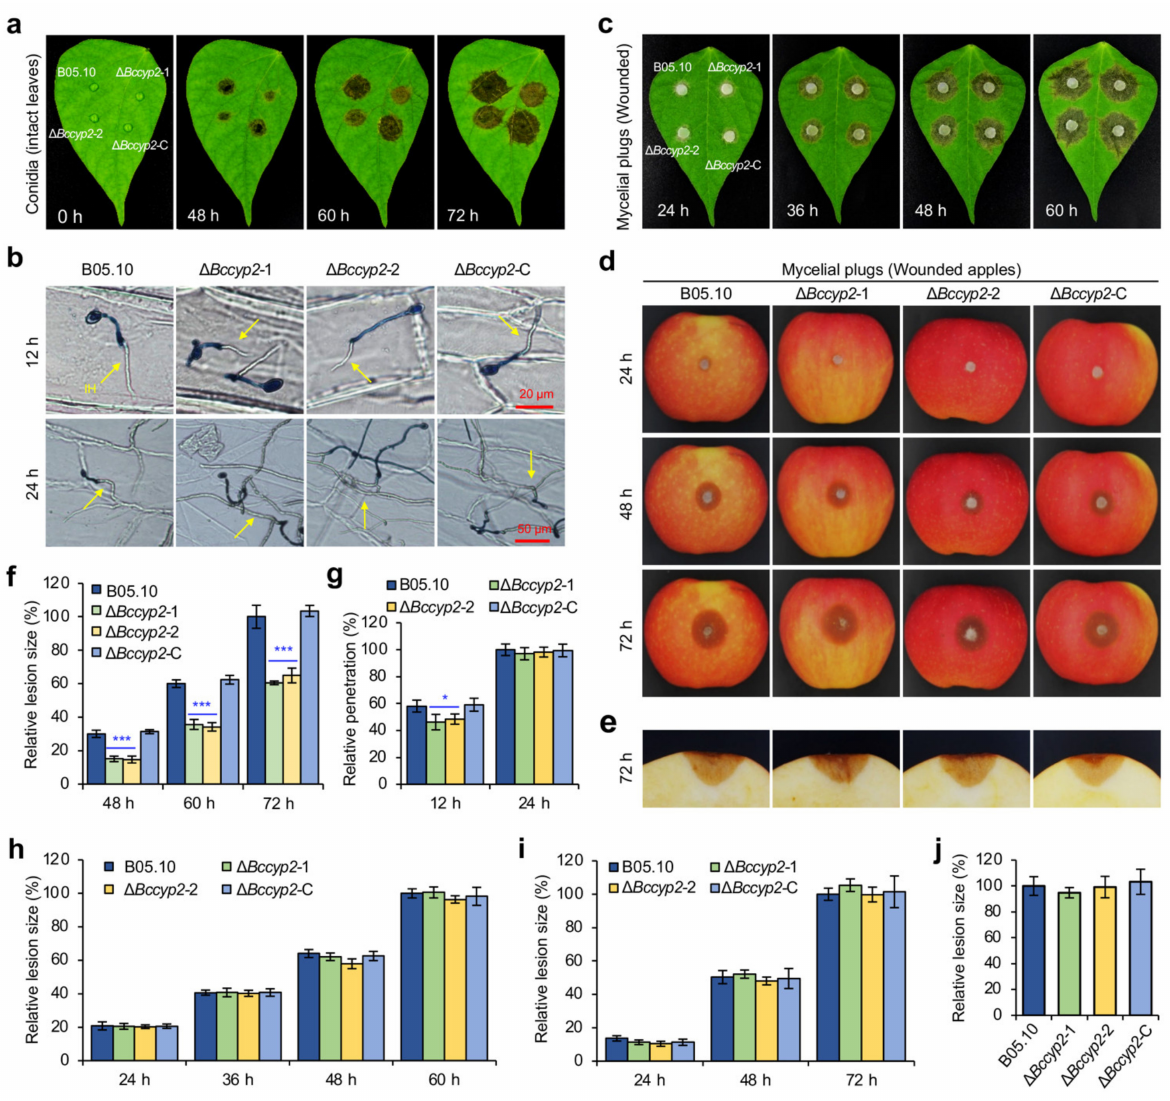
Figure 4. Loss of BcCYP2 in B. cinerea impairs virulence of the pathogen. ( a ) Deletion of BcCYP2 reduces the virulence of B. cinerea . Conidial suspensions (2 × 10 5 conidia/mL in 1 liquid CM, 5 µ L) of the WT, ∆ Bccyp2 , and complement 2 strains were inoculated on intact green bean leaves. At 0, 48, 60, and 72 hpi, the inoculated leaves were photographically documented. ( b ) Penetration assay of the test strains. Conidia (2 × 10 5 conidia/mL, 5 µ L) of the strains were inoculated on onion epidermis and cultured at 20 ◦ C in the dark. At 12 and 24 hpi, the inoculated epidermal cells were stained with lactophenol aniline blue and then observed and photographically documented. ( c , d ) Deletion of BcCYP2 does not affect invasive hyphal expansion in planta. Mycelial plugs of each strain were inoculated on artificially wounded green bean leaves ( c ) or apple fruits ( d ) and the lesions were photographically documented at the indicated hpi. ( e ) The cross-section of lesions on wounded apple fruits. ( f ) Quantification of lesion sizes caused by the indicated strains on green bean leaves shown in ( a ). ( g ) Quantification of penetration by the indicated strains on onion epidermal cells shown in ( b ). ( h – i ) Quantification of lesion sizes caused by the indicated strains on wounded green bean leaves or apple fruit shown in ( c , d ), respectively. ( j ) Quantification of lesion sizes caused by the indicated strains on apple fruits shown in ( e ). Data represent means ± SD from three independent experiments. *, ***: significance at p < 0.05 and 0.001, respectively. IH: invasive